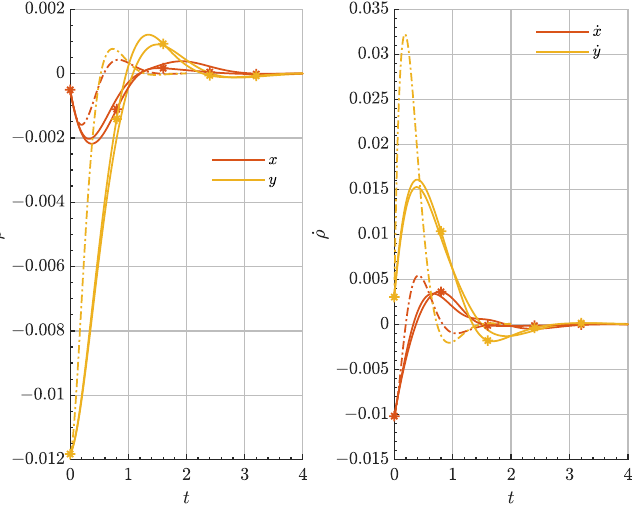
Figure 8. Relative state evolution for the LQR (solid), SDRE (*) and AL-iLQR (dashed) controllers.